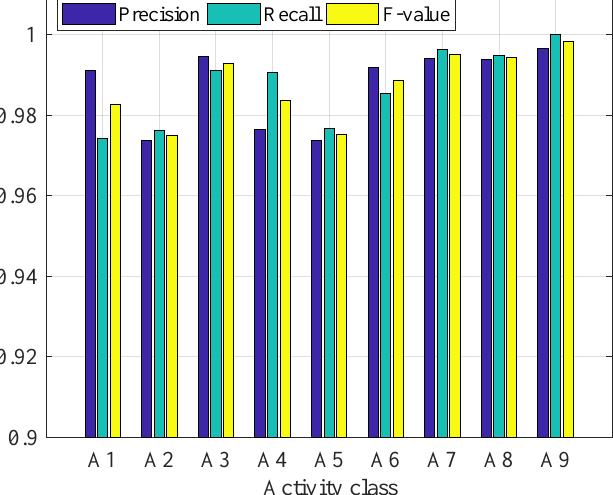
Figure 9. The performance for each type of activities with the best